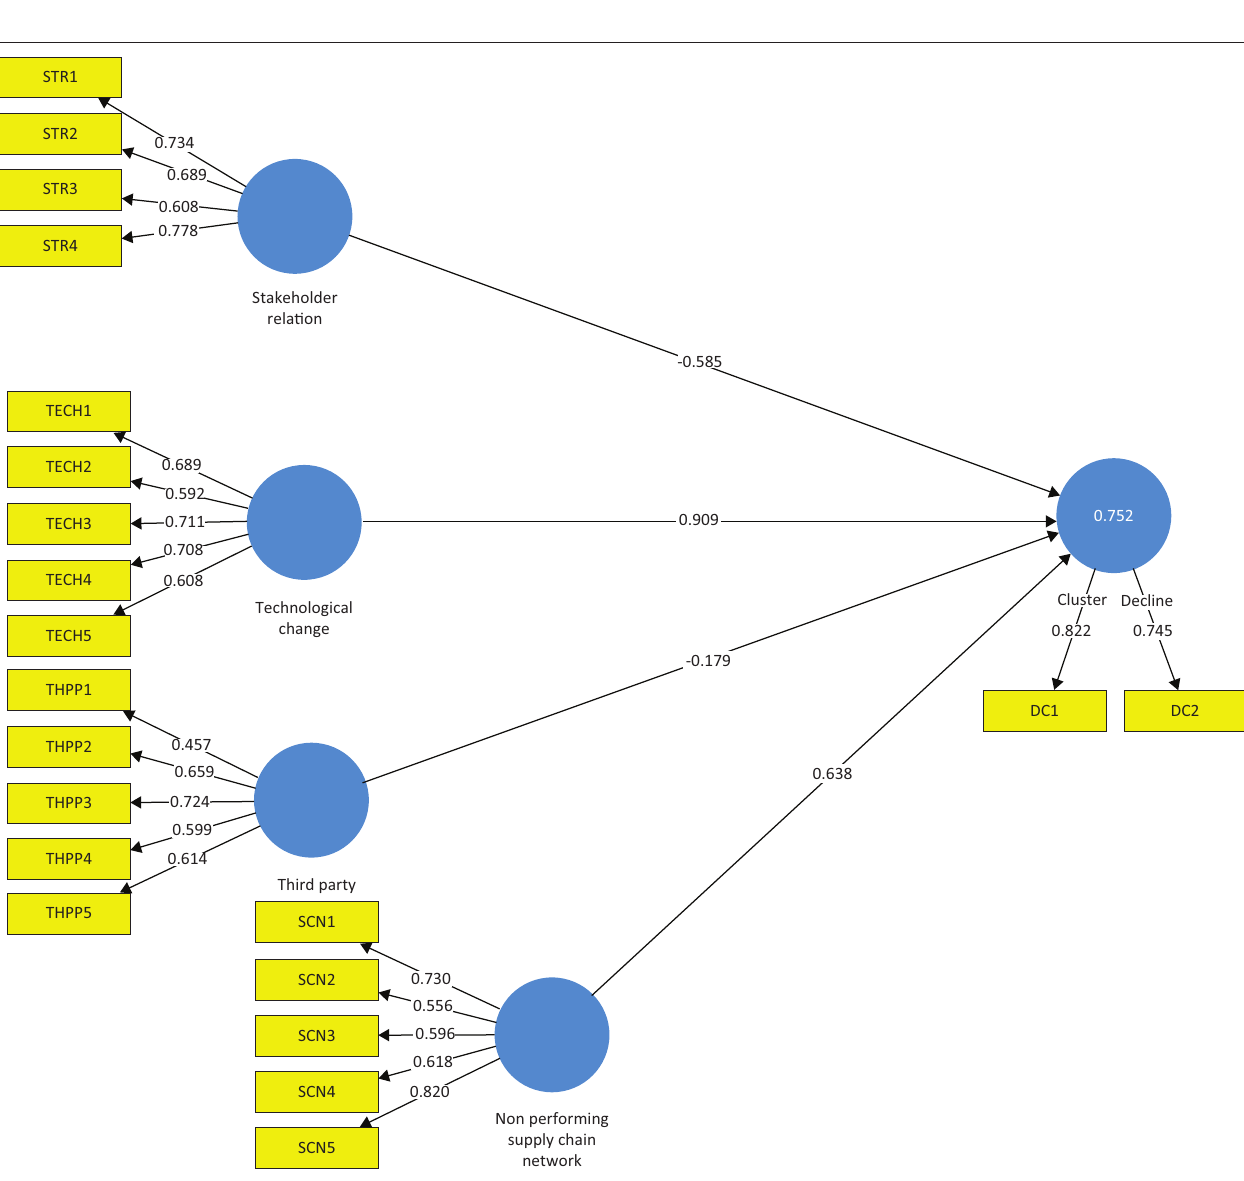
FIGURE 2: Path estimation result.